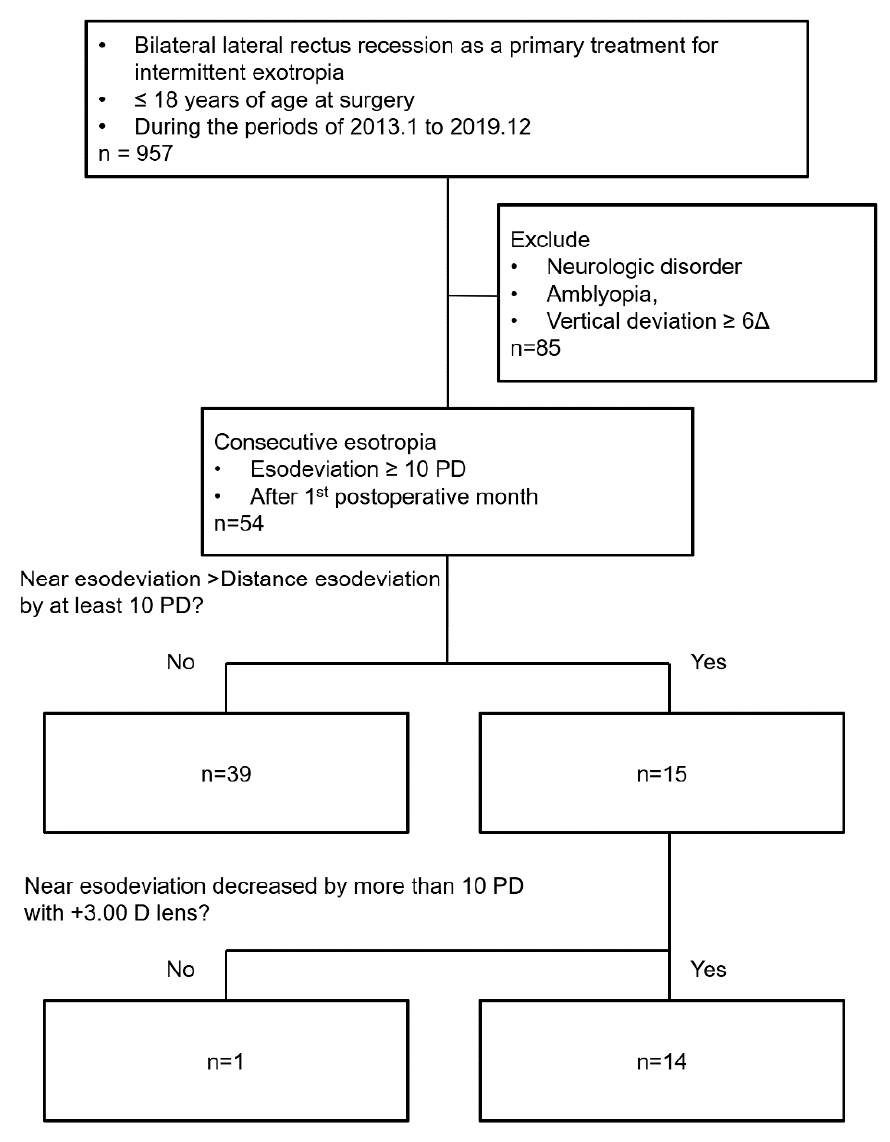
Figure 1. A flow chart for identifying patients with high accommodative convergence/accommodation (AC/A) ratio consecutive esotropia. Table 1. Comparison of the pre- and postoperative characteristics between high AC/A and normal AC/A consecutive ET patients.